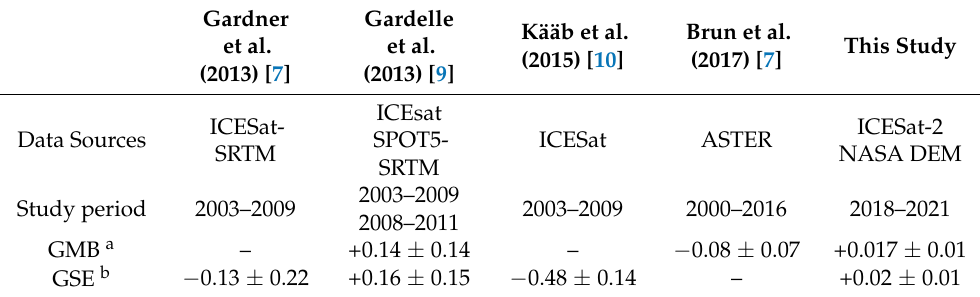
Table 4. Comparison of research results on the different glacier variation trends in